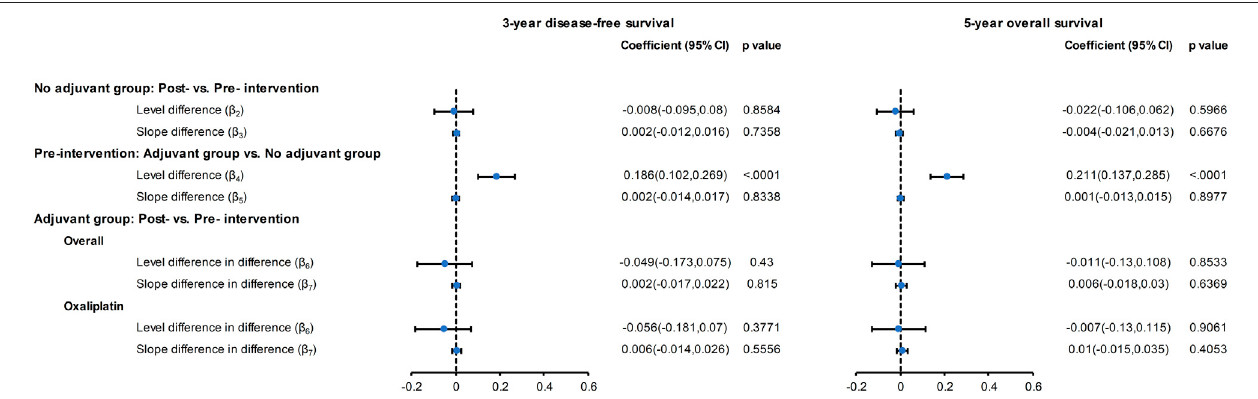
FIGURE2| Forestplotoftheregressioncoef fi cientsfortheCITSfortheoverallcohortandfortheoxaliplatincohort.PleaserefertoeMethod1intheSupplementfor explanation of the regression coef fi cients ( β 2 – β 7 ).